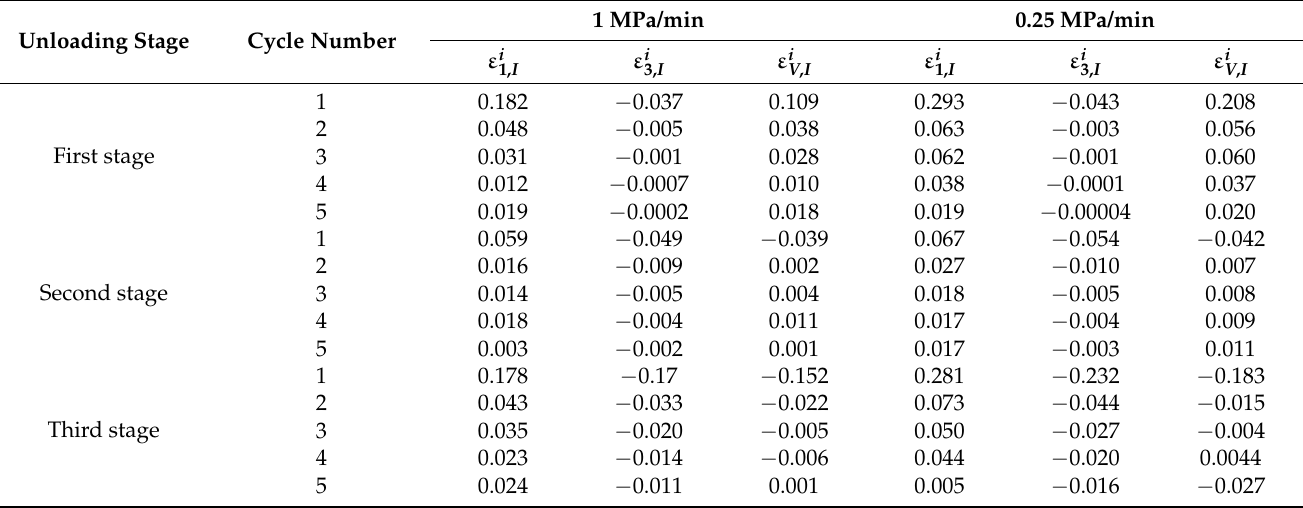
Table 3. Irreversible strain in a single